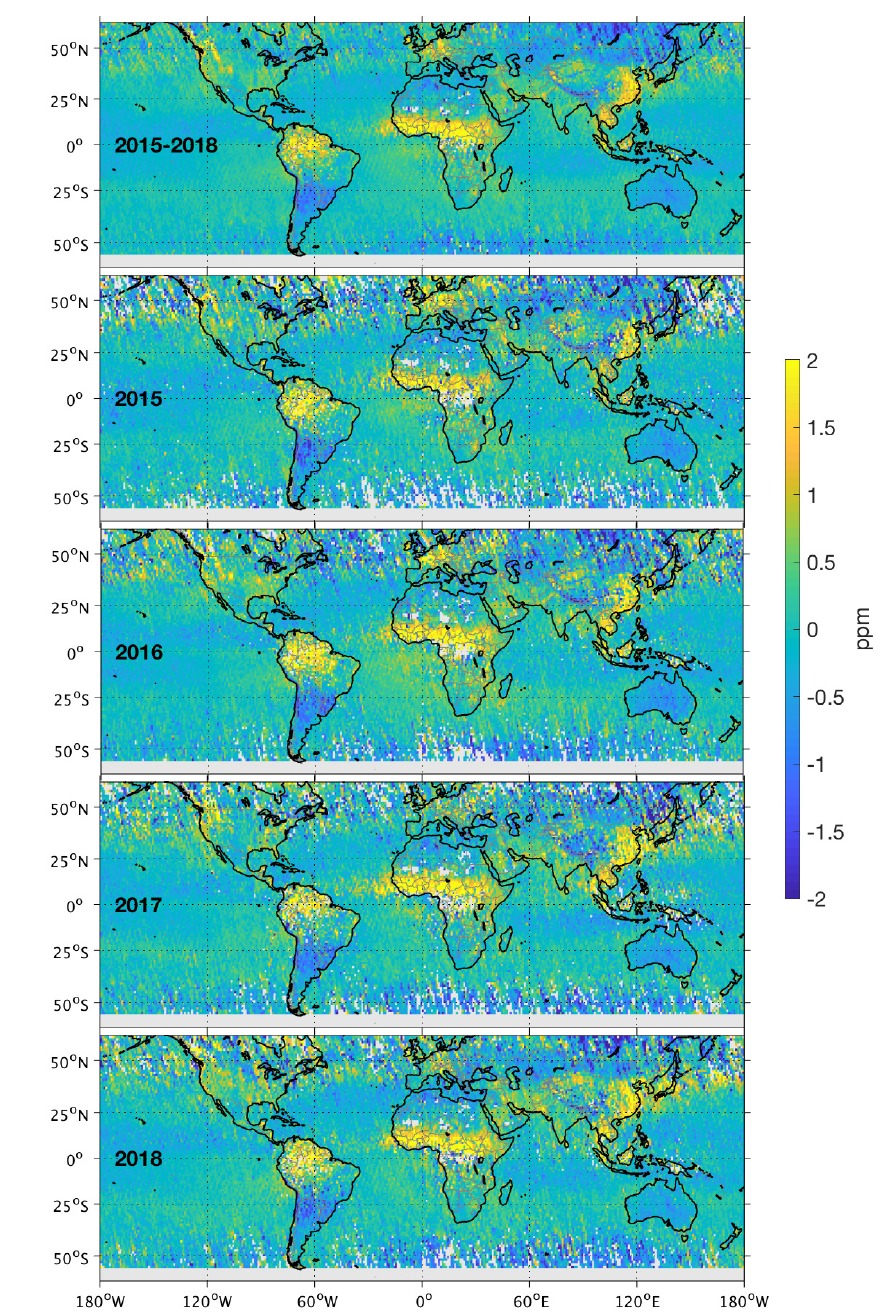
Figure 3. Global XCO 2 anomalies as seen by OCO-2. The first panel corresponds to the four-year average 2015–2018, while the second, third, fourth, and fifth panels include the annual mean anomalies for the years 2015, 2016, 2017, and 2018,